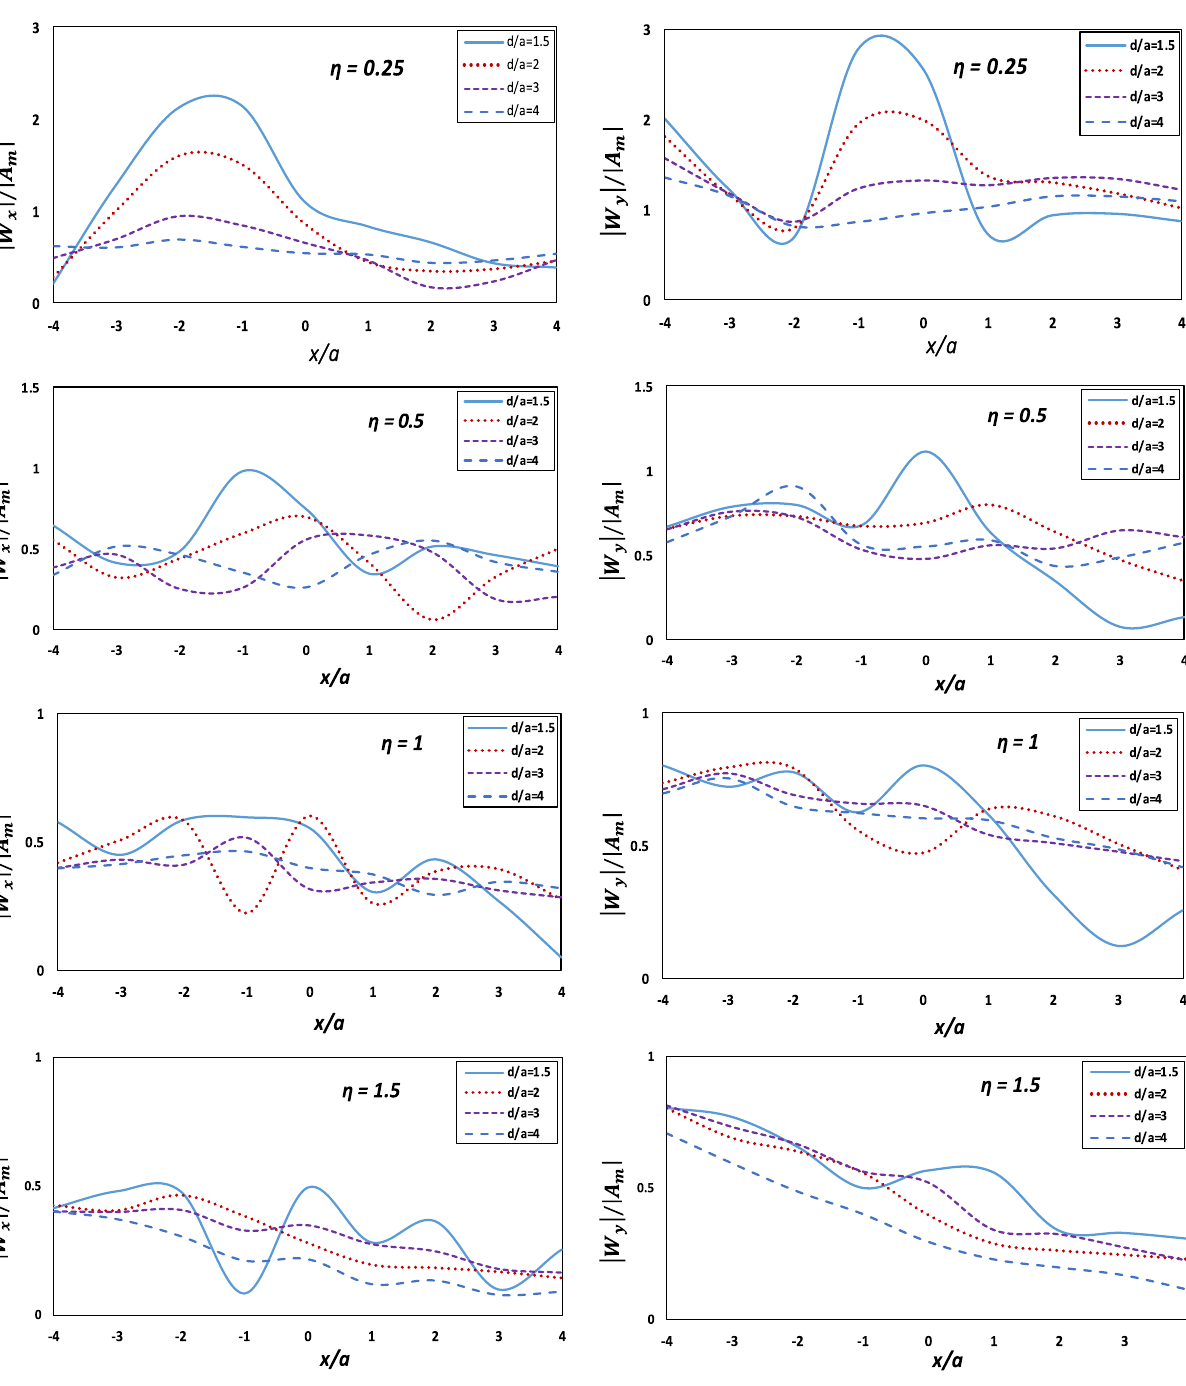
Fig. 9 Normalized amplitudes of the total horizontal and vertical displacements on the ground surface for different depth ratios at each constant dimensionless frequency under incident